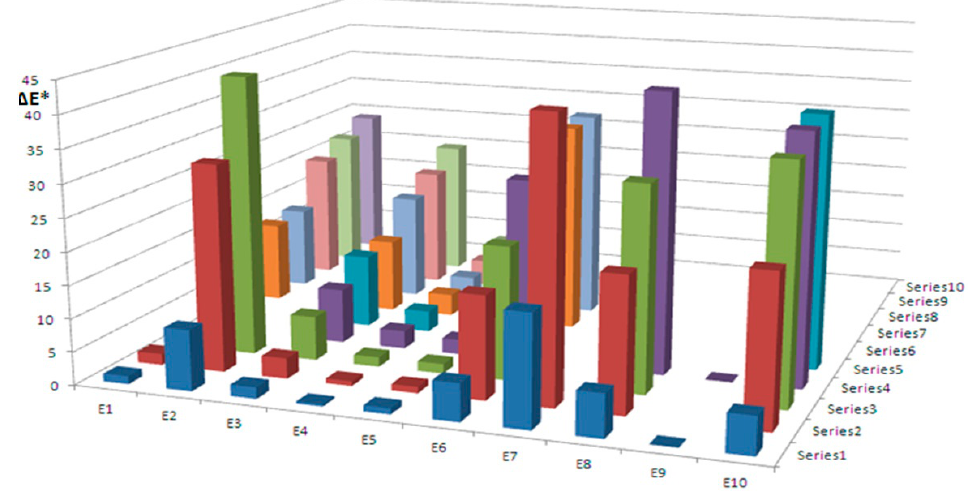
Figure 13. Cleaning efficiency by CIE L*a*b* colorimetry with E1–E10 systems ( Δ E* is the chromatic deviation).